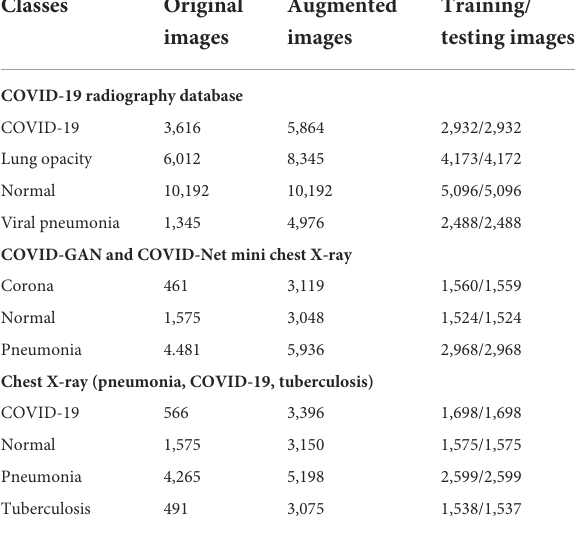
TABLE 1 Brief description of selected